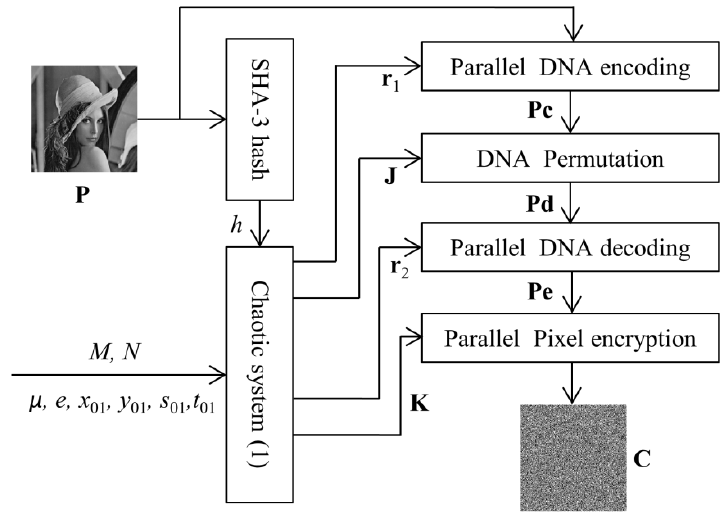
Figure 7. The block diagram of the overall image encryption scheme.